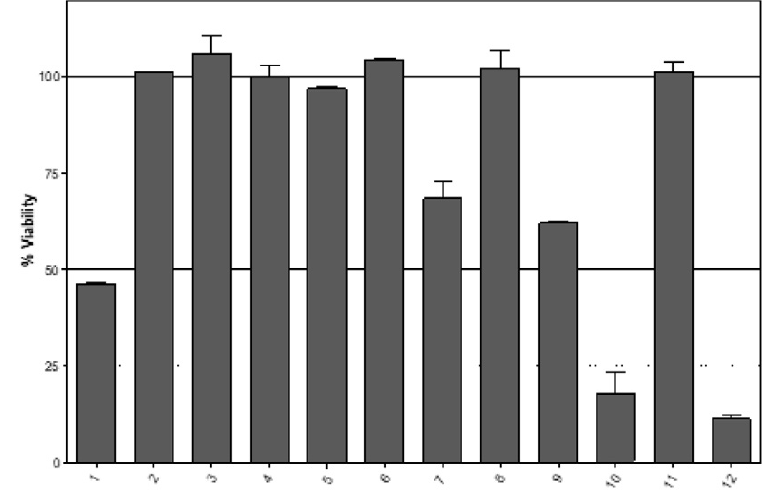
Figure 9. The residual percentage parasite ( Trypanosoma brucei ) viability ± SD obtained for compounds 1 – 12 .